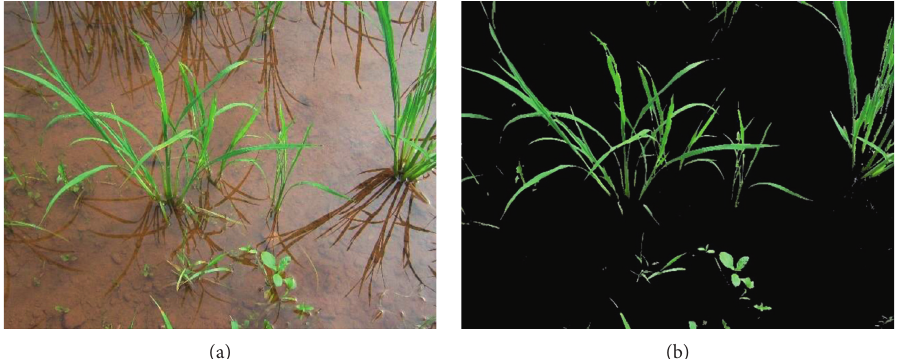
Figure 3: (a) Image taken at a distance of 1.22m from the ground using the Canon camera and (b) the corresponding background subtracted image.